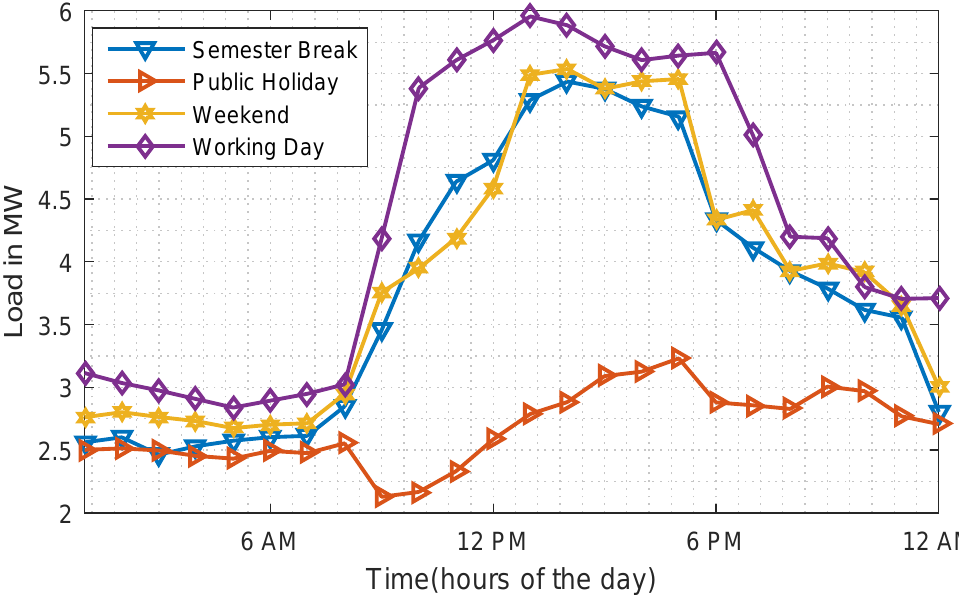
Figure 2. Daily load profile of Universiti Teknologi PETRONAS (UTP) microgrid.